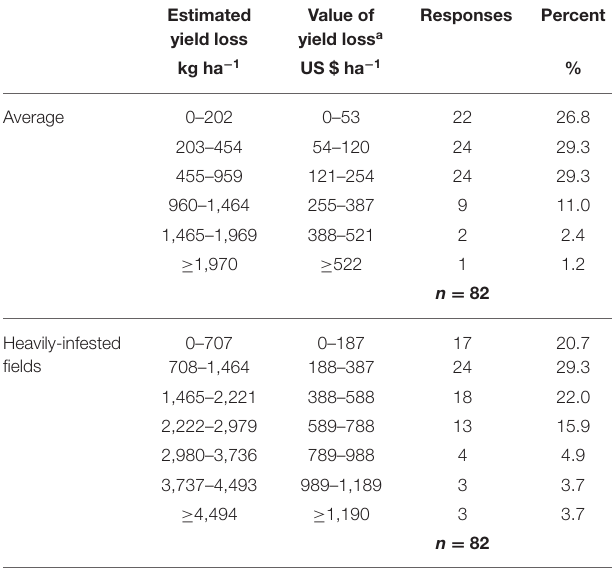
TABLE 9 | Estimated average rice yield loss attributed to Echinochloa crus-galli (L.) P. Beauv. in Arkansas rice fields and estimated yield loss in most heavily infested fields (maximum potential loss) as reported by survey